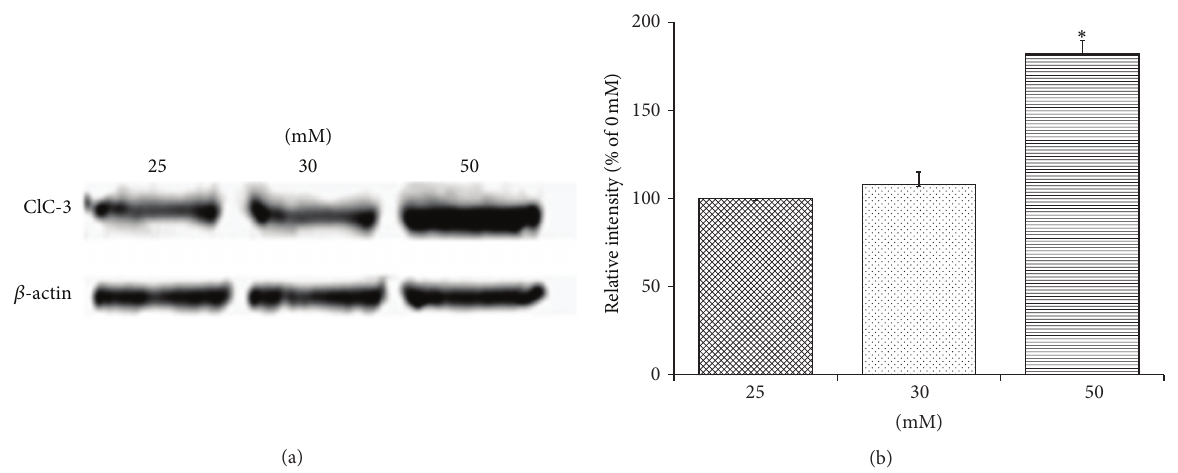
Figure 4: Western blot analysis of HT22 cell lysates from control and low and high glucose groups, at 24 h, for ClC-3 protein expression (a) and quantification of its intensity levels (ratio of ClC-3 band to standard 𝛽 -actin band) (b) showed a significant increase in the expression level of ClC-3 in high glucose group ( 𝑃 < 0.05